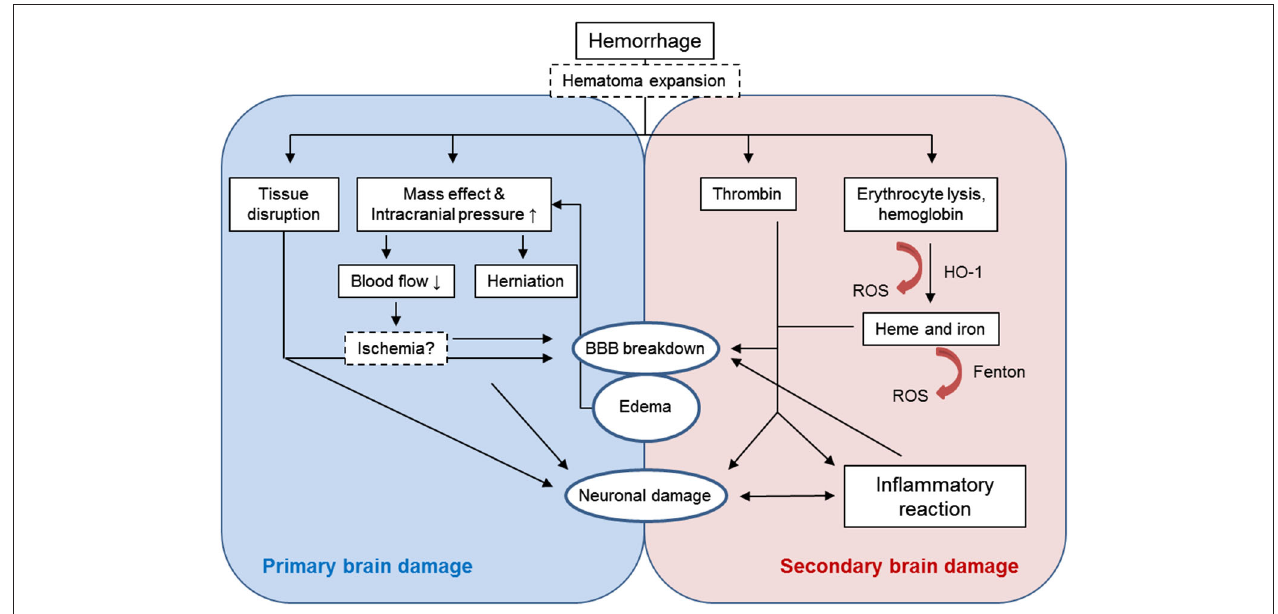
FIGURE 1 | Primary and secondary brain damage after intracerebral hemorrhage